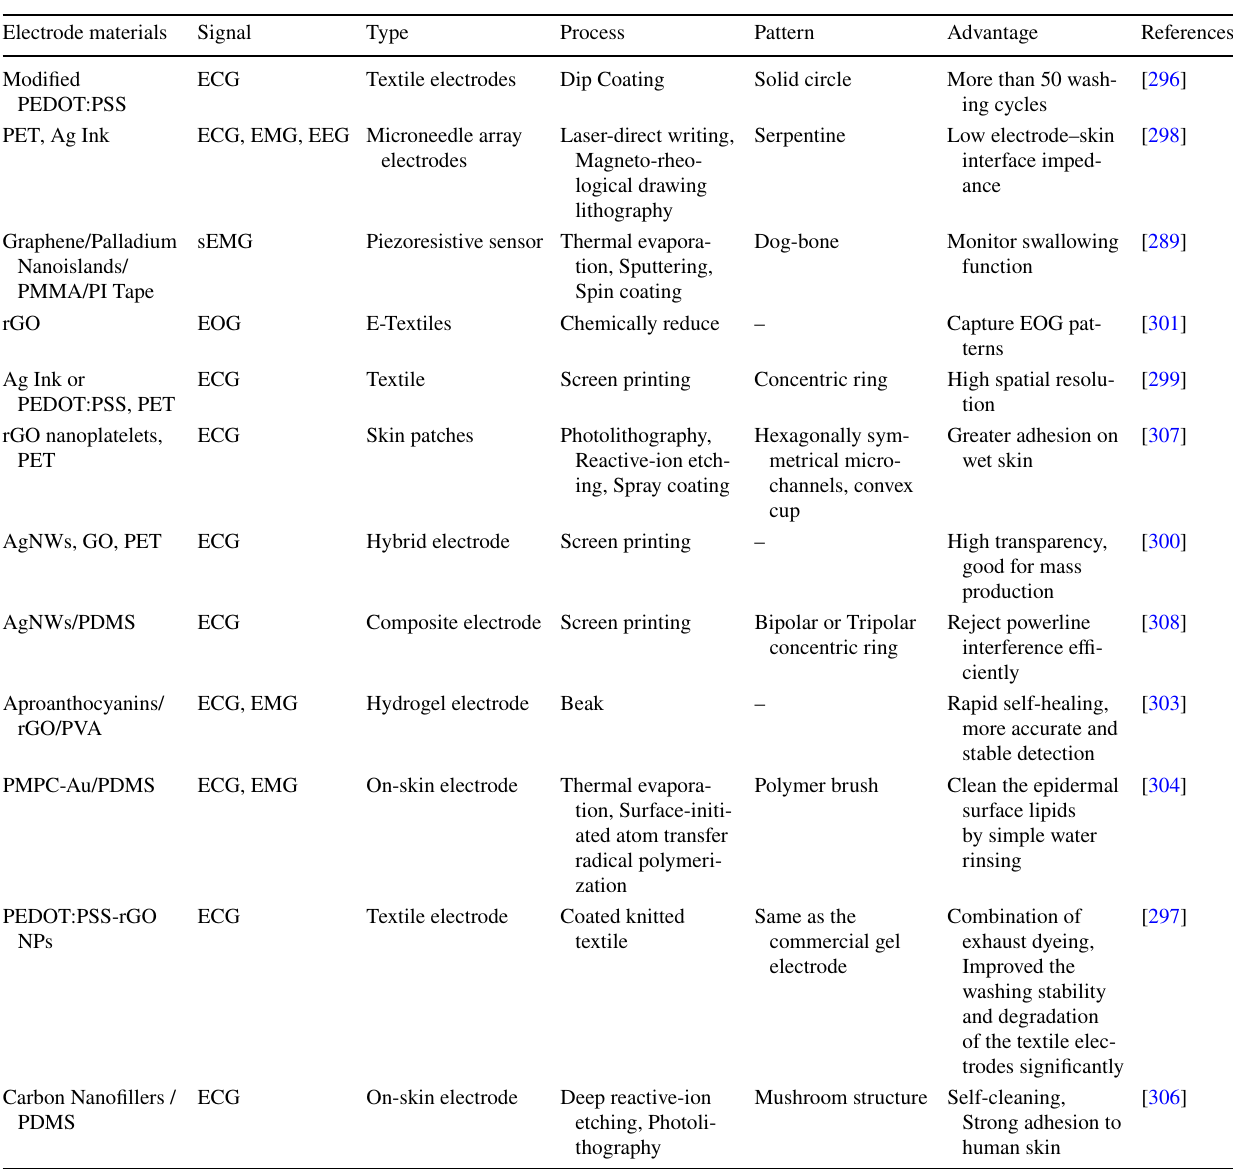
Table 3 Characteristics of different electrodes Electrode materials